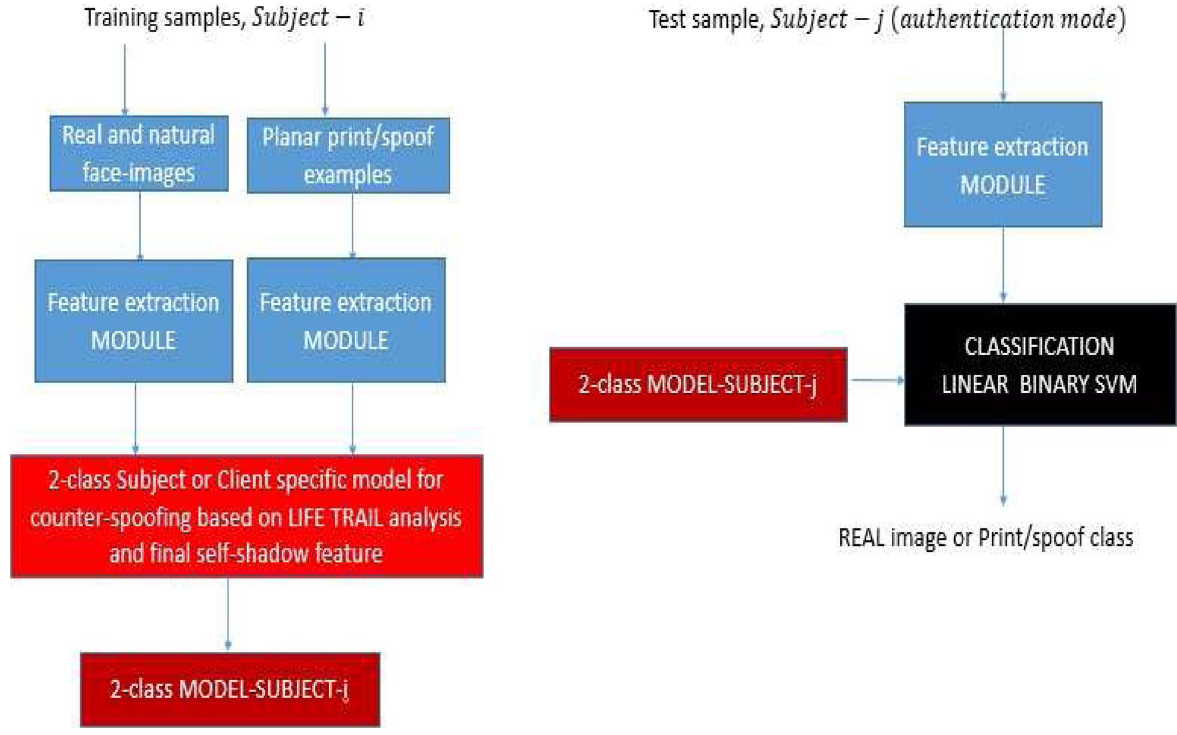
Fig. 2 Block-diagram of training and classification/detection module